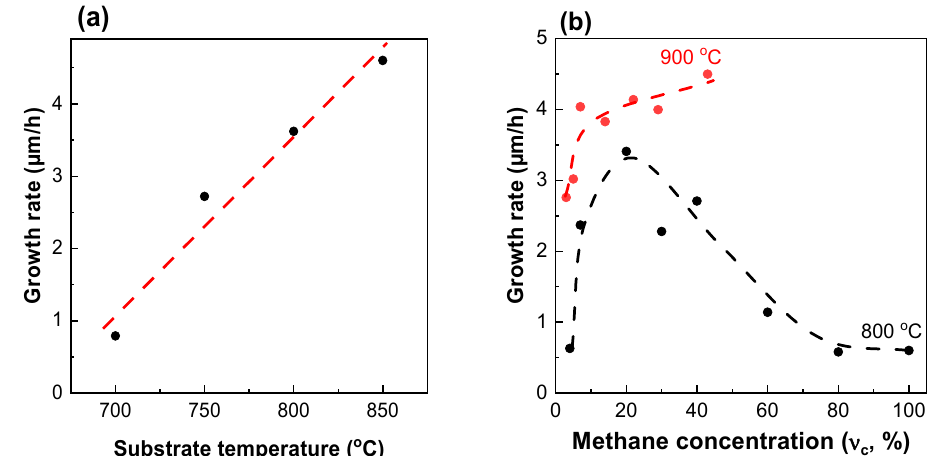
Figure 4. Growth rates of polycrystalline diamond films synthesized at ( a ) fixed methane concen- tration 𝜈 𝑐 = 40% and different substrate temperatures T s ; ( b ) fixed T s = 800 °C and T s = 900 ° С with different 𝜈 𝑐 concentrations. The lines are guides for the eye.